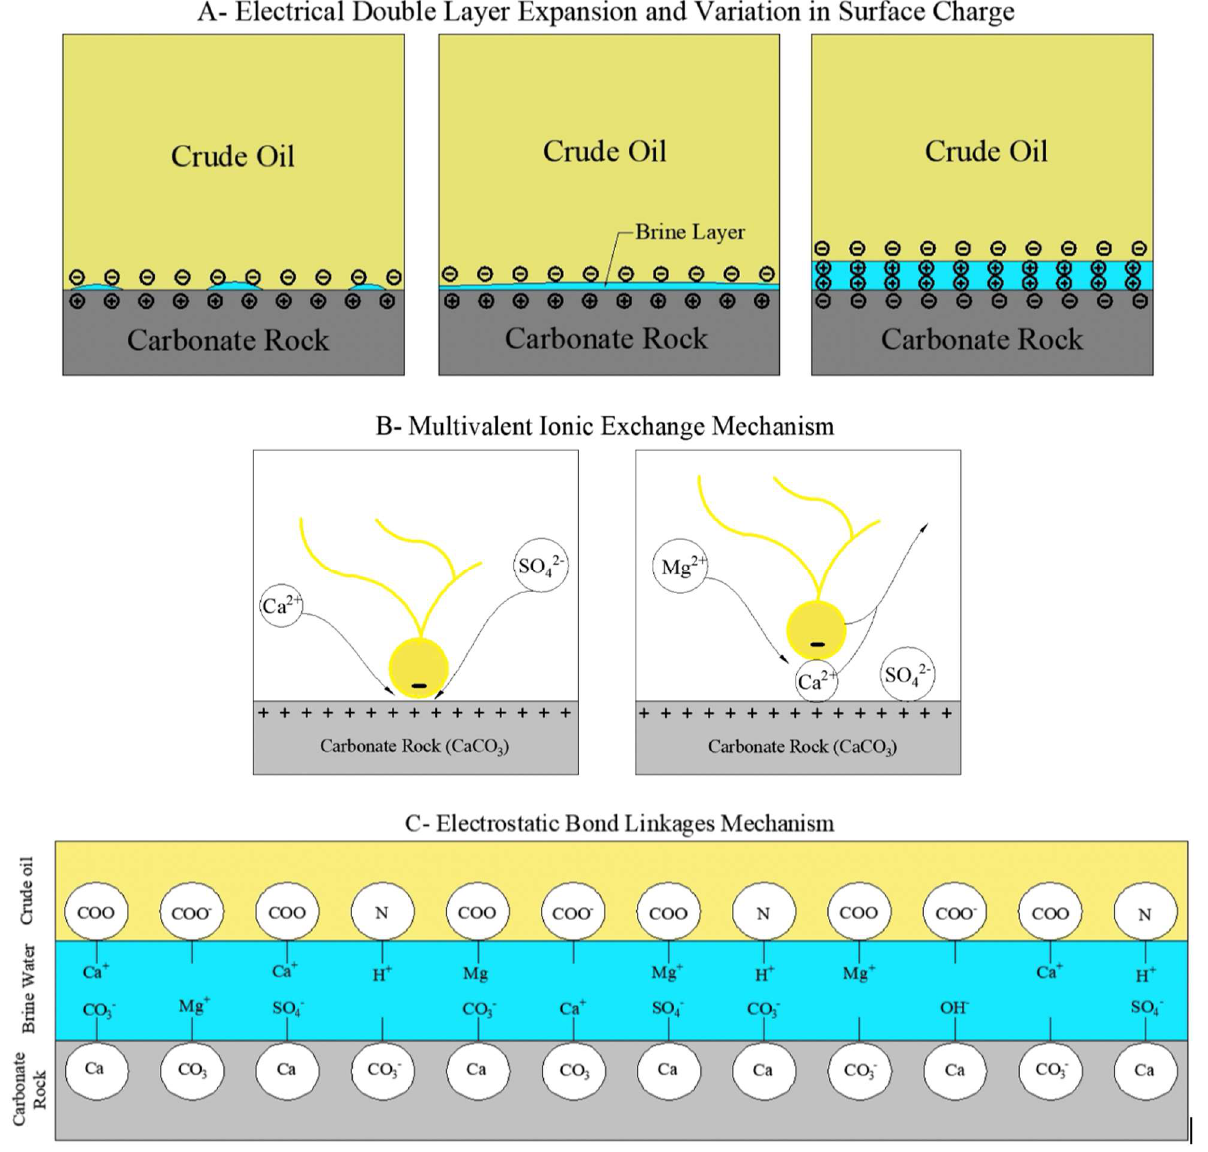
Figure 6. Rock-fluid mechanisms under LSFW in carbonate rocks; ( A ) EDL and surface charge var- iation; ( B ) MIE mechanism and; ( C ) Electrostatic bond interactions at the oil-brine-rock interface [103–105].